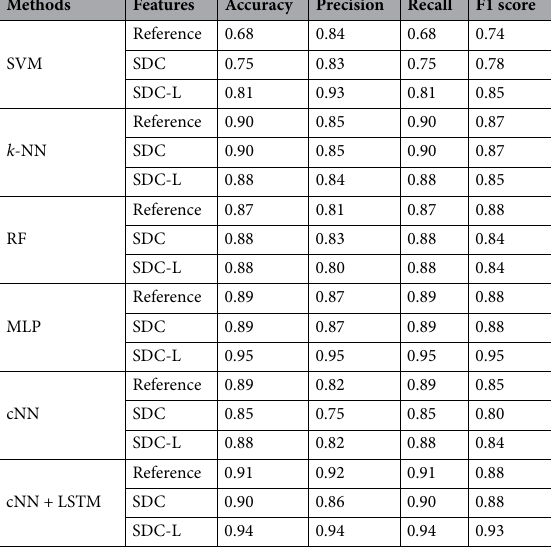
Table 4. Performance comparison. SVM, support vector machine; k -NN, k -nearest neighbors; RF, random forest; MLP, multi-layer perceptron; cNN, convolutionary neural network, LSTM, long short term